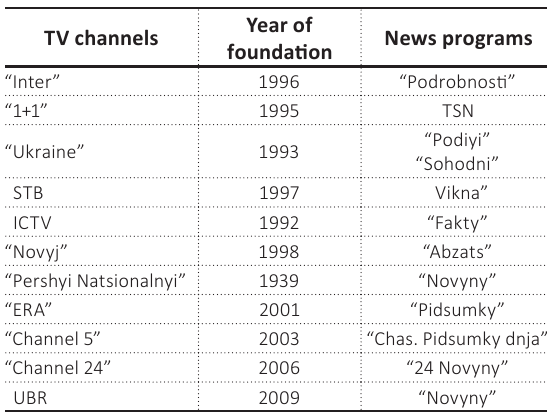
Table 1. TV channels subjected to rhetorical